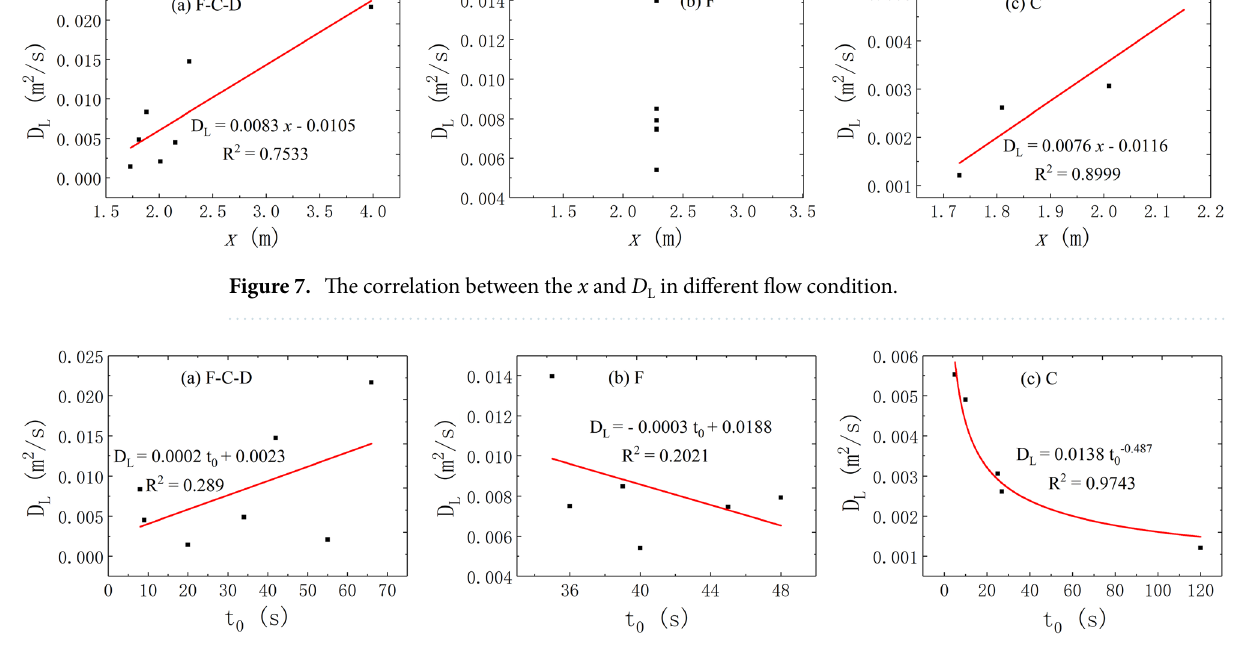
Figure 8. The correlation between the t 0 and D L in different flow